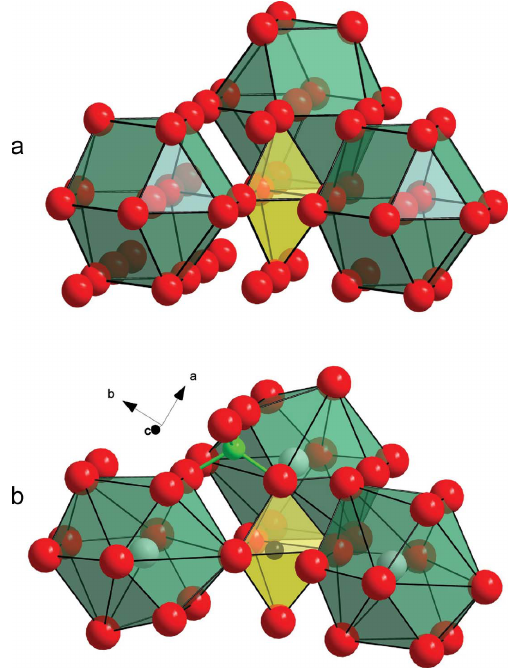
Figure 4 Drawing parallels between the danburite-II crystal structure and an ideal h.c.p. structure. ( a ) A view of an h.c.p. structure based on hexagonal cubooctahedra (shown in green). A void with trigonal–bipyramidal geometry is shown in yellow. ( b ) A representation of the crystal structure of danburite-II based on a distorted h.c.p. structure made of Ca and O atoms. CaO 11 polyhedra (defective hexagonal cubooctahedra) are shown in green. The void with trigonal–bipyramidal geometry is occupied by an Si atom (shown in black). The bright-green sphere towards the top centre of panel ( b ) represents the B atom occupying a tetrahedral void.